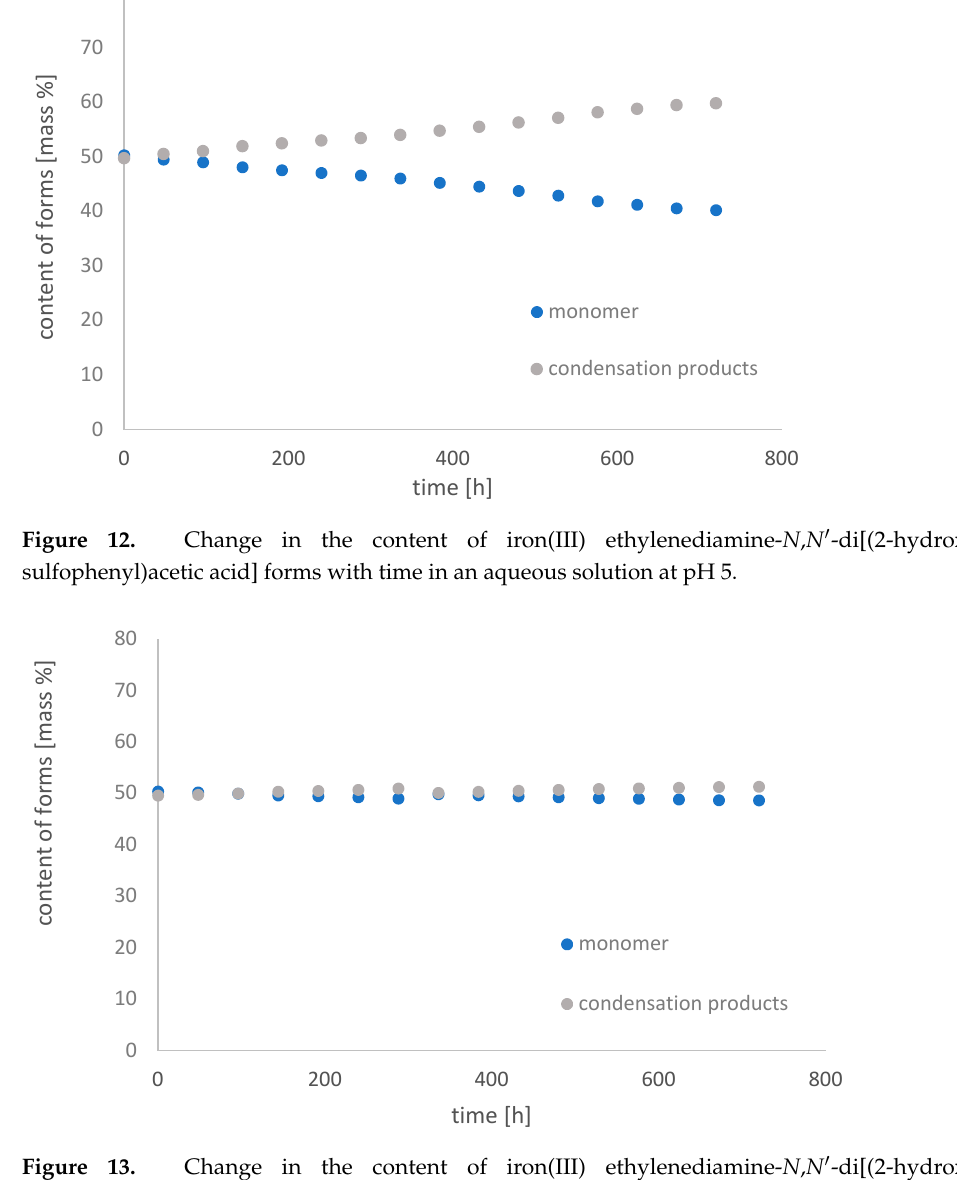
Figure 13. Change in the content of iron(III) ethylenediamine- N,N ′ -di[(2-hydroxy-5- sulfophenyl)acetic acid] forms with time in an aqueous solution at pH 7.